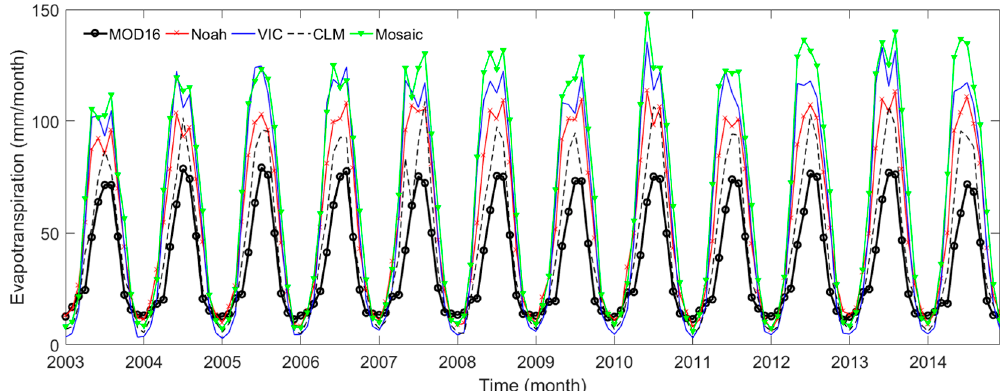
Figure 3. The time series of monthly evapotranspiration from MOD16 and GLDAS.